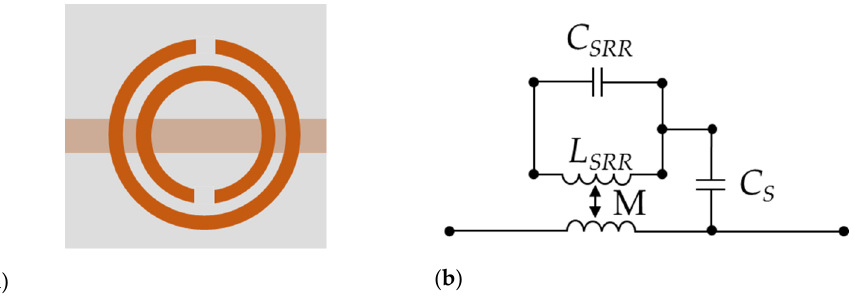
Figure 2. ( a ) The structure of the split resonance ring (SRR). ( b ) The equivalent circuit.